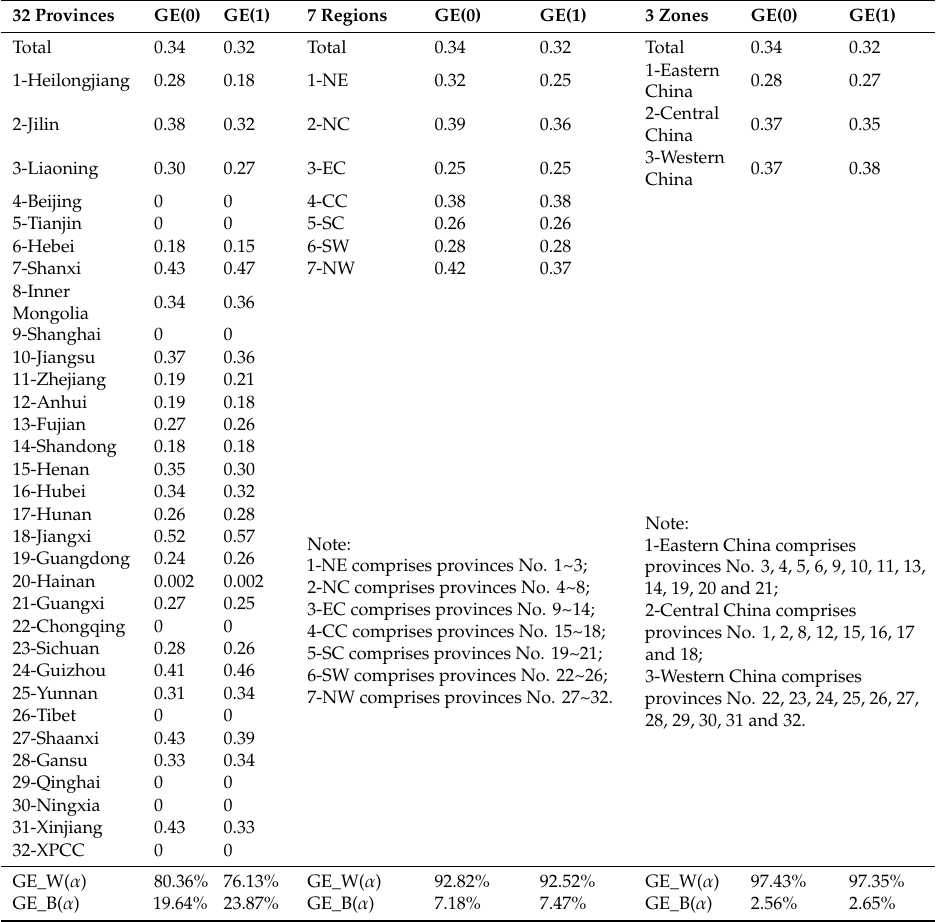
Table 5. Total GE( α ) Values based on City’s average score per 10,000 People (subgroups by province, region and